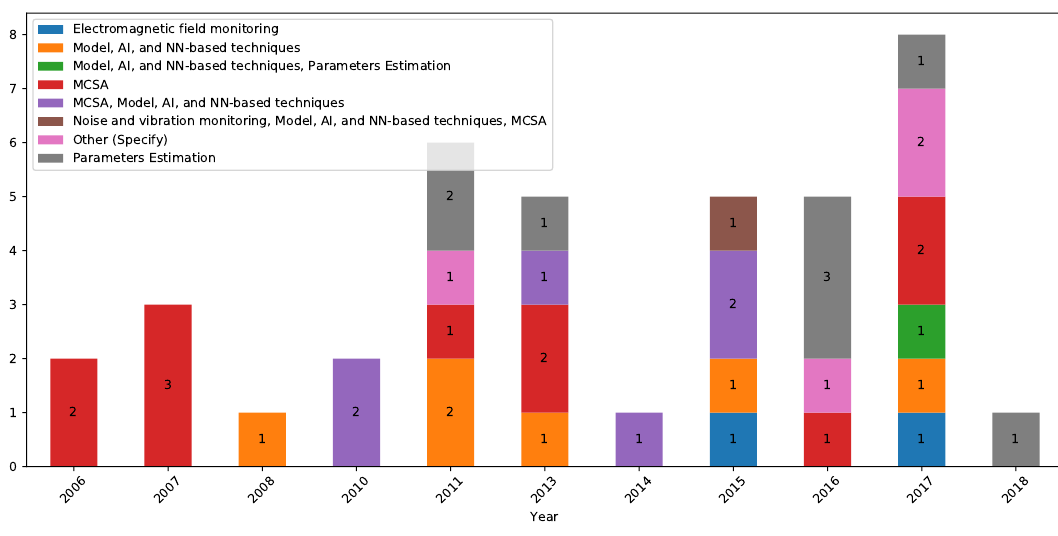
Figure 2. Distribution of the used techniques over the publication